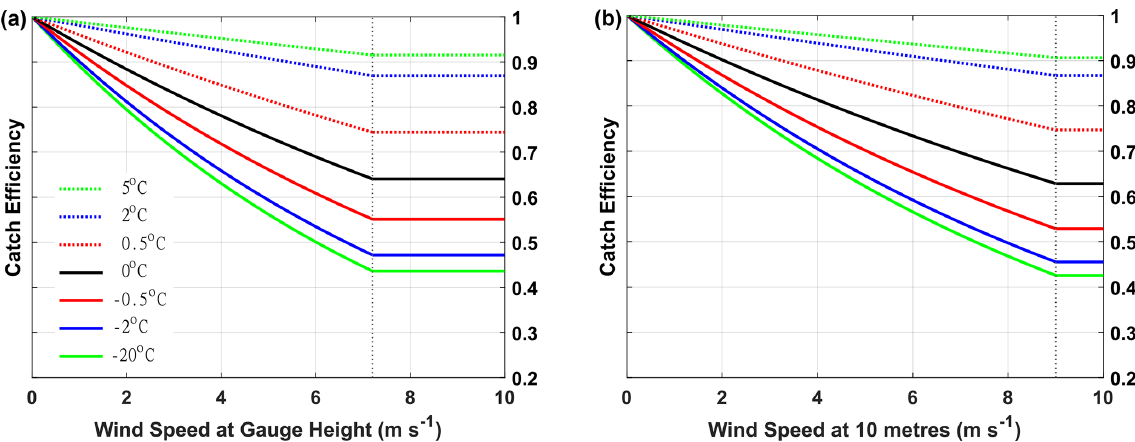
Figure 2. The SPICE universal transfer function (Eq. 1) plotted with coefficients for the single Alter Shield and wind measured at gauge height (a) and 10m (b) for temperatures of + 5, + 2, + 0.5, 0, − 0.5, − 2, and − 20 ◦ C. The inflection point where the catch efficiency is set to a minimum occurs at wind speed thresholds ( U t ) of 7.2ms − 1 (for gauge height wind) and 9.0ms − 1 (for 10m wind) and is marked by the vertical dotted line.